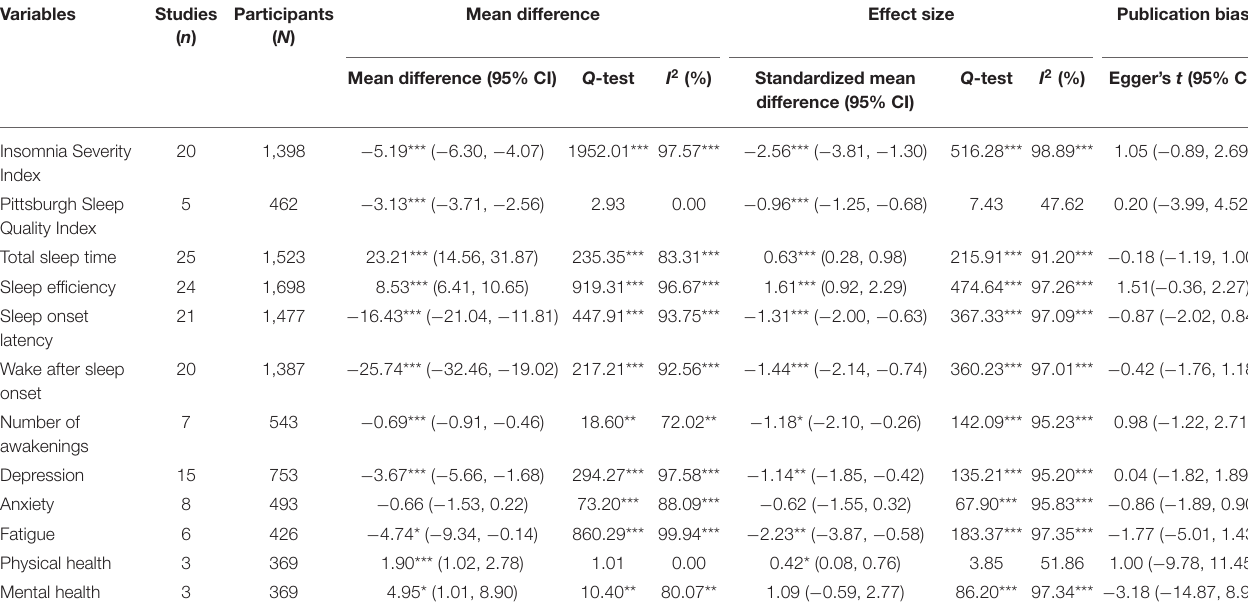
TABLE 2 | Total effects of CBT on all